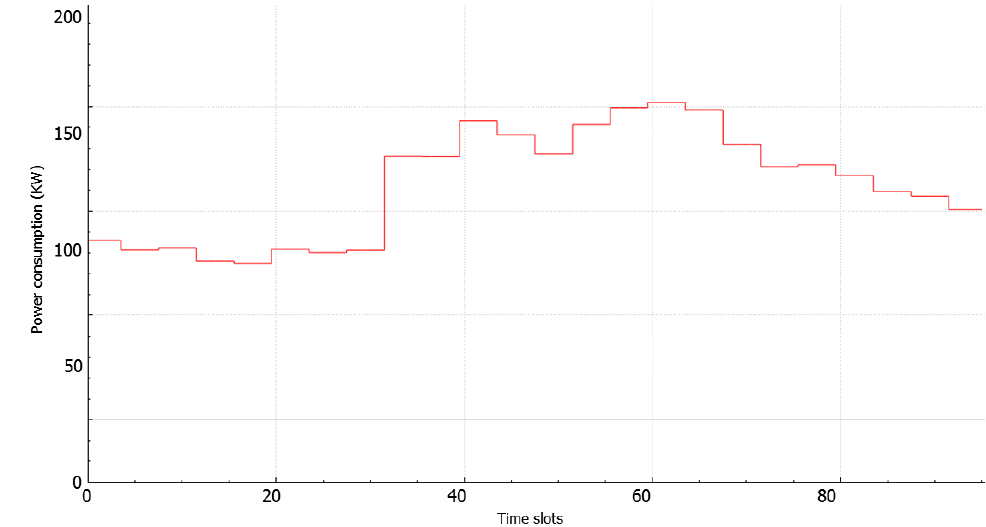
Figure 2. Hourly electricity consumption on 15 May 2018.